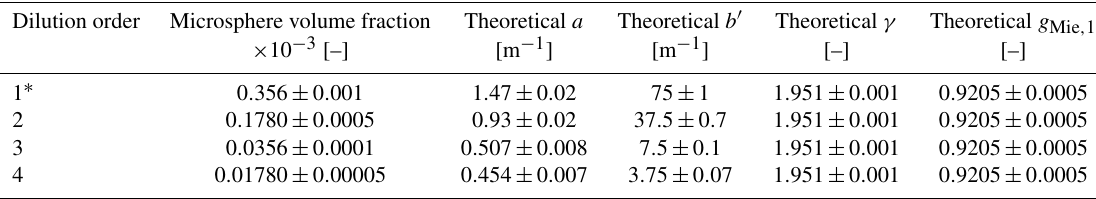
Table 1. Theoretically calculated IOPs for four concentrations of polystyrene microspheres in water used to first calibrate and then validate the instrument